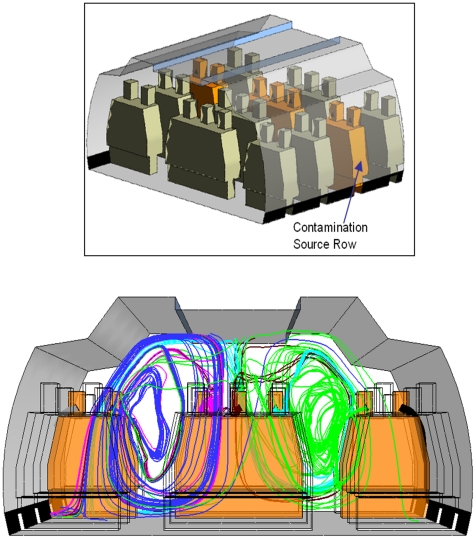
Infected Passenger Schematic.Seat Position from Left to Right: LK FED BA. Contaminant Streamlines Shown for Scenario 1 Breathing and Coughing.